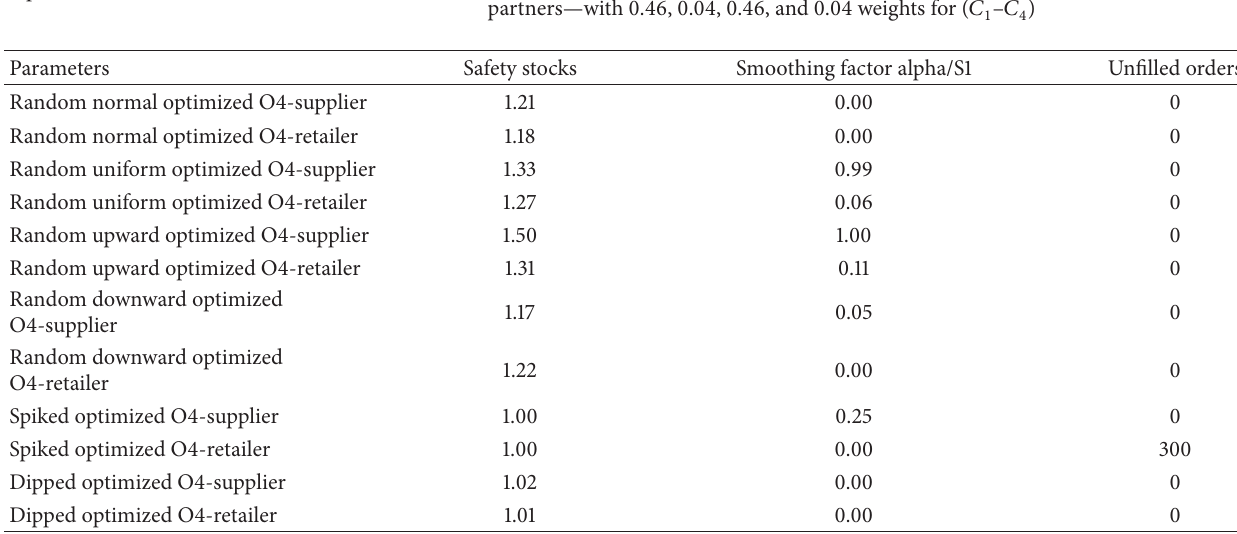
Table 5: Parameter settings and results from optimization run with differential weights for the components of objective function. Optimization